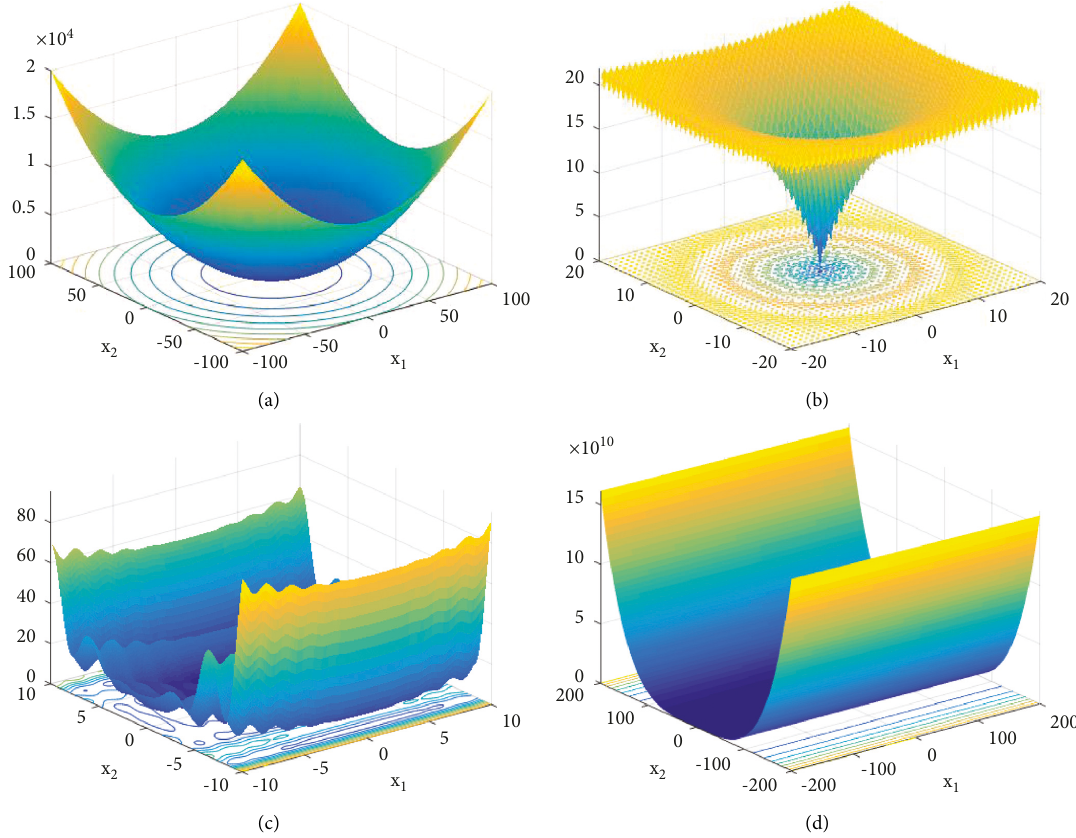
1 ). (b) Ackley function( F 2 ). (c) L´evy function( F 3 ).